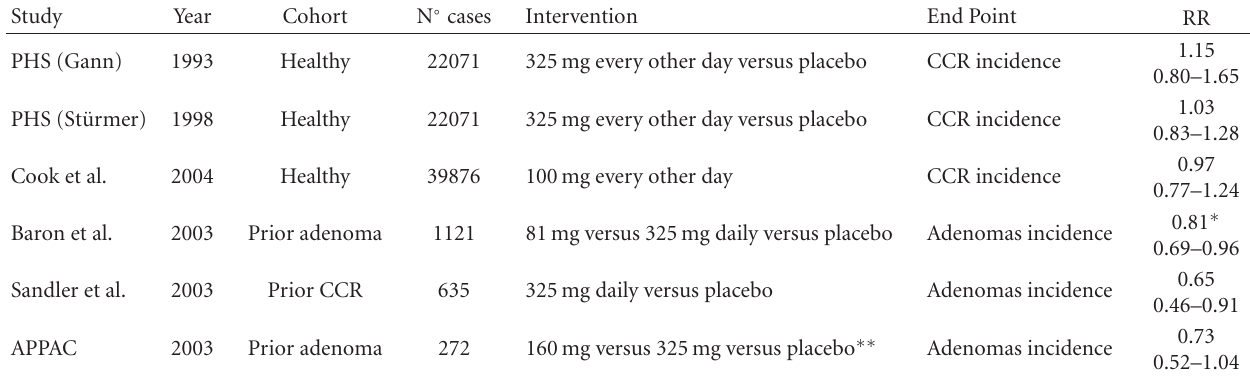
Table 1: Results of colorectal cancer and adenoma incidence in aspirin